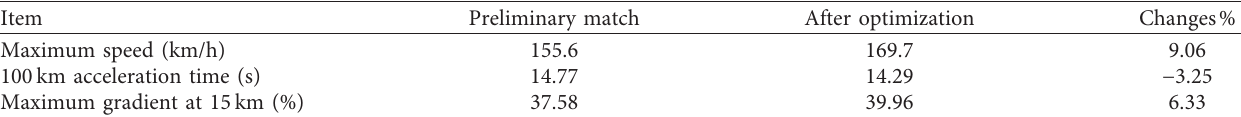
Figure 5: The SOC curve in different driving cycles before and after optimized parameters. Table 4: Comparison of dynamic performance indicators after